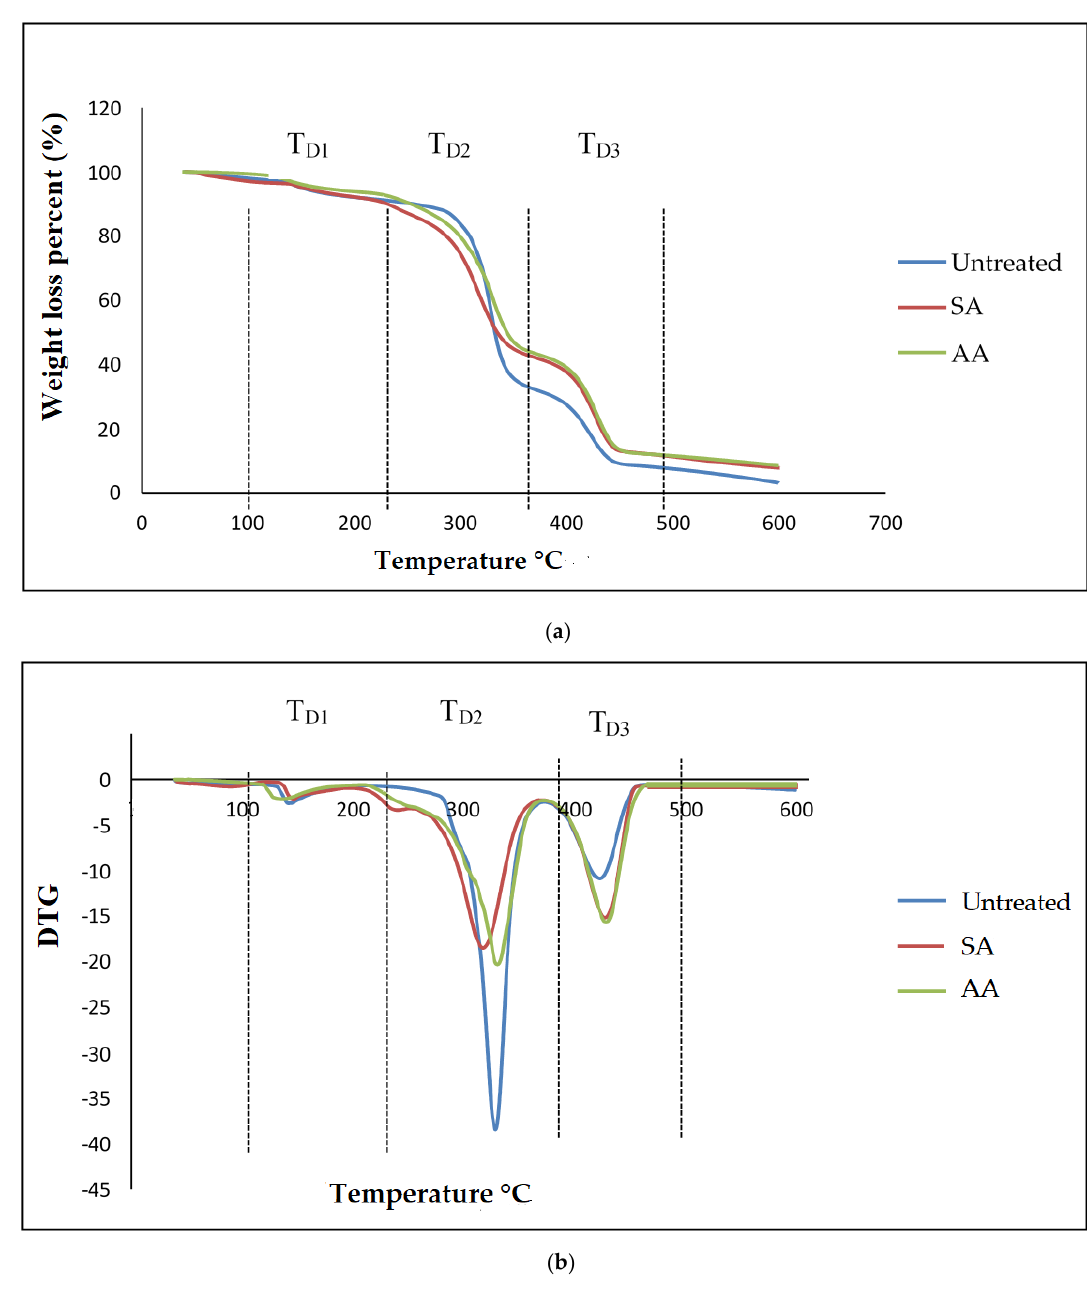
Figure 10. ( a ) TGA curves of PS/TPS blend with a ratio of 80/20 (TPS/PS). ( b ) DTG curves of blend with a ratio of 80/20 (TPS/PS).